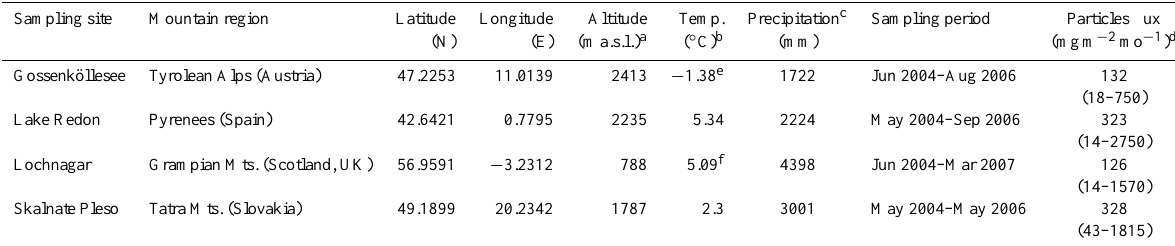
a Metresabovesealevel. b Meantemperatureforthewholesamplingperiod. c Totalprecipitationmeasuredfortheentiresamplingperiod. d Meanparticledepositionfluxandrangeinbrackets. e FromOctober2004toAugust2006. f